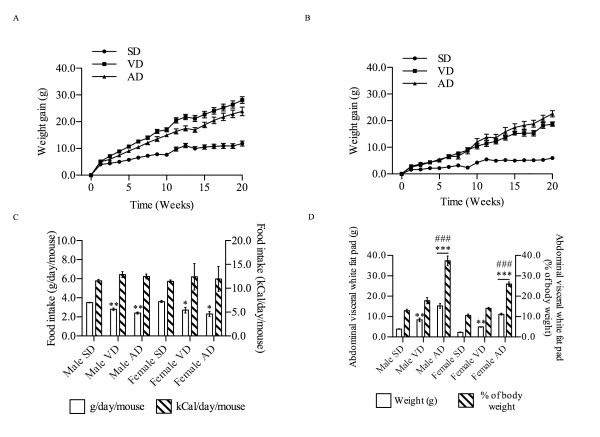
Kinetic of weight gain in male (A) and female (B) mice (n = 10). The mean cumulative food intake (C) was evaluated during the protocol in g/day/mouse (white column) and kCal/day/mouse (hatched column). White fat pad mass (D) is expressed as the weight of adipose tissue extracted from the abdominal visceral region of each mouse (white column) and transposed in percentage of total body weight (hatched column) at the time of the sacrifice (n = 9). * P < 0.05, ** P < 0.01, *** P < 0.001 vs. SD; ### P < 0.001 vs. VD.